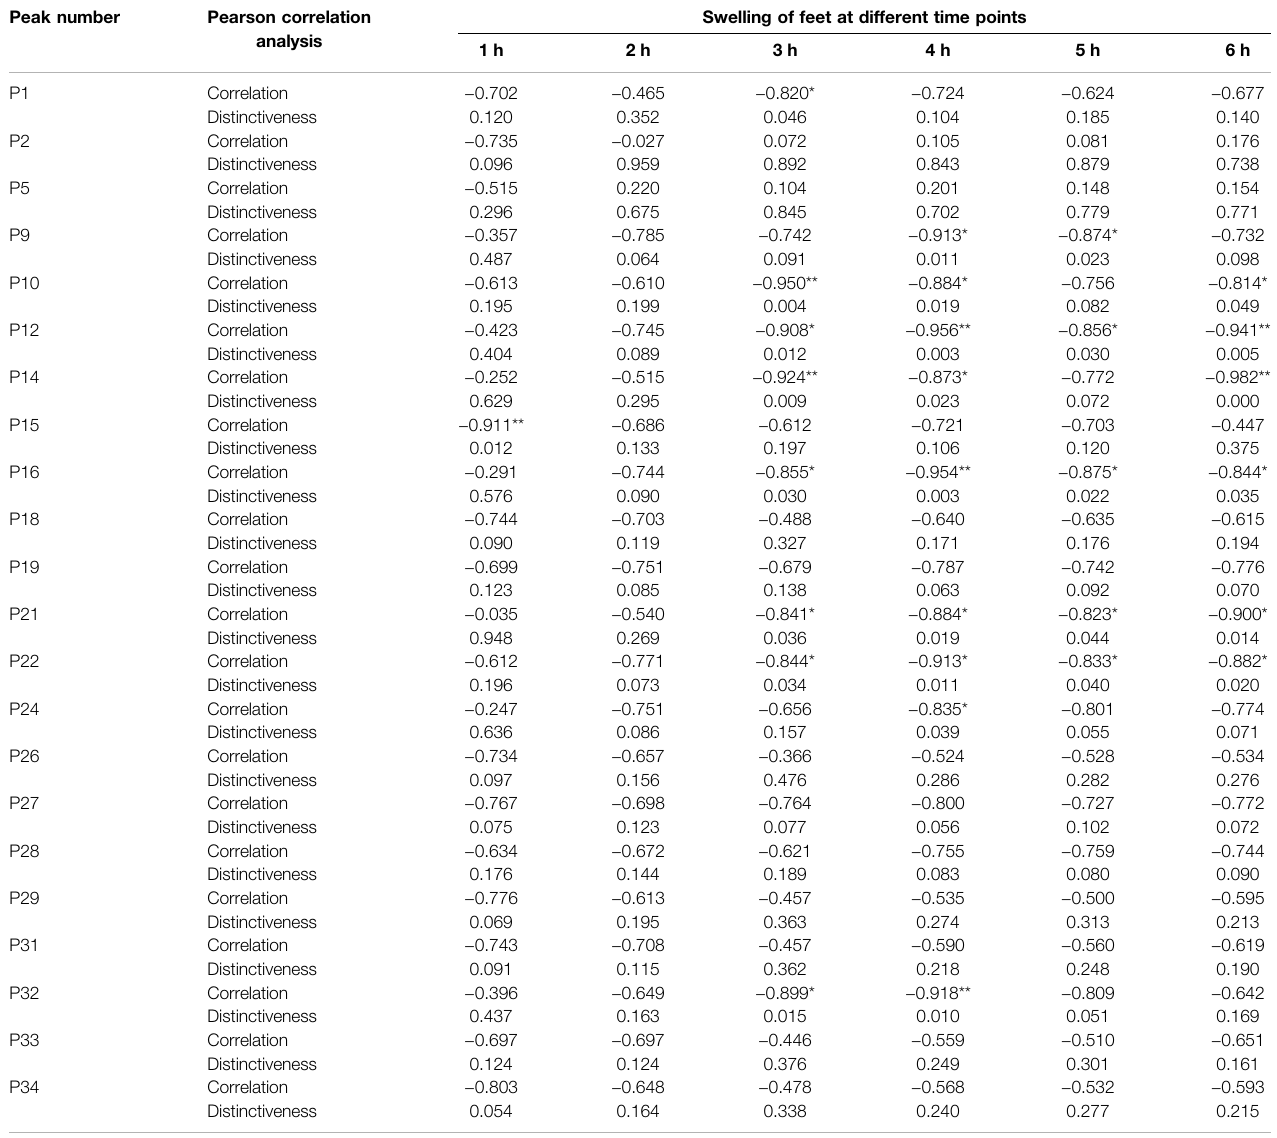
TABLE 3 | Pearson correlation analysis